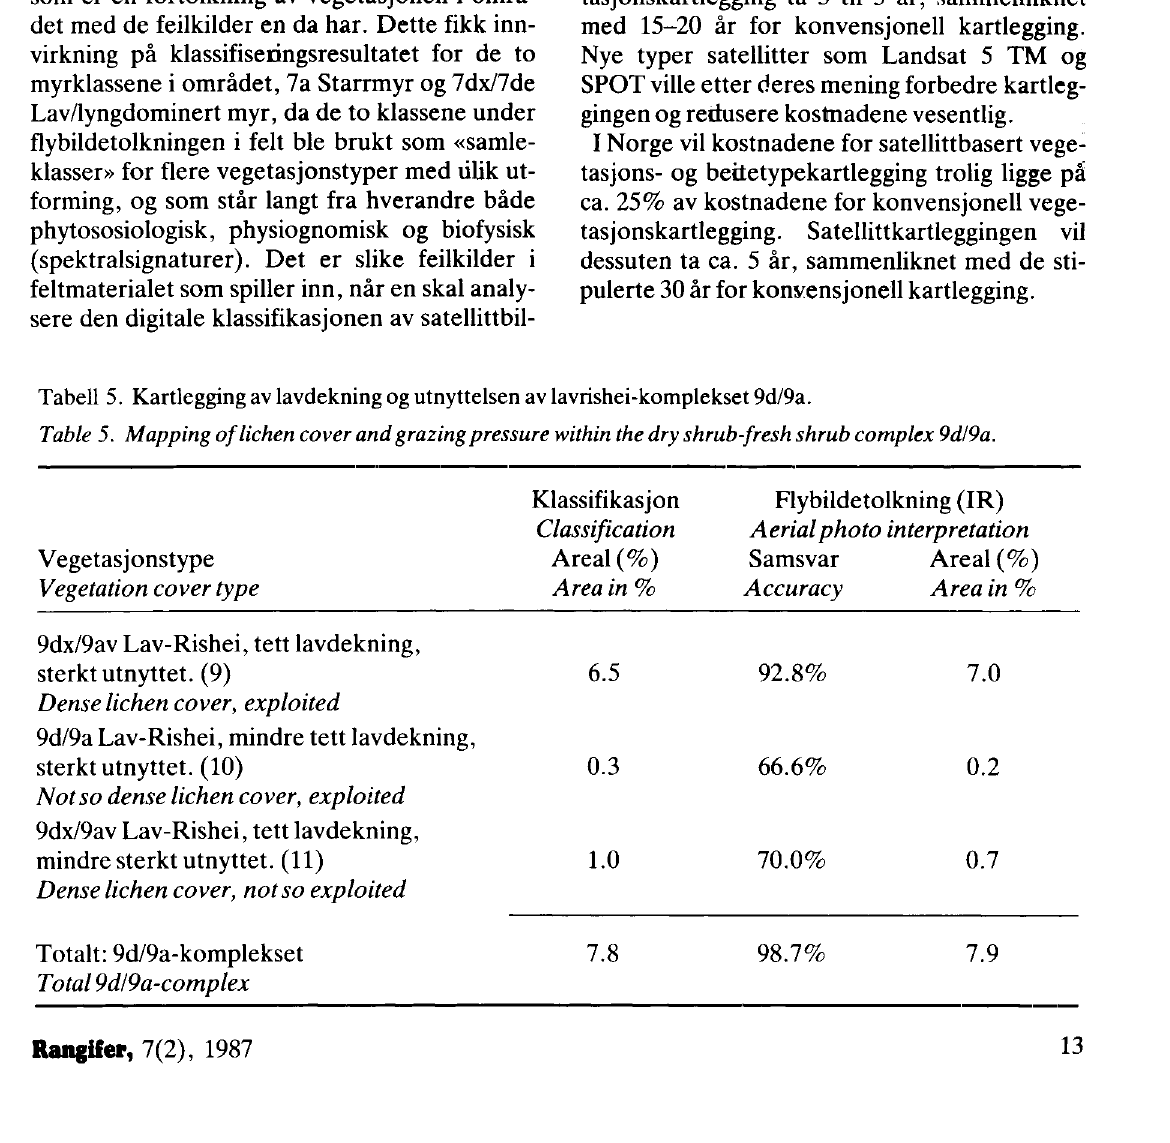
Table 5. Mapping of lichen cover and grazing pressure within the dry shrub-fresh shrub complex